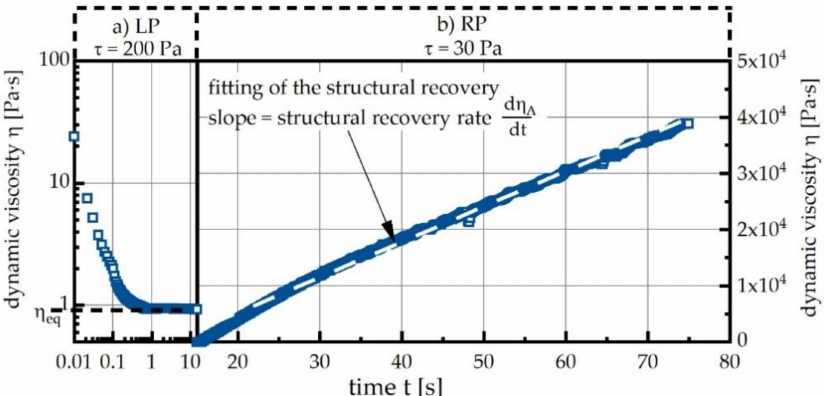
Figure 2. Exemplary depiction of the change in dynamic viscosity observed during the loading phase (LP) and the recovery phase (RP): ( a ) LP causes a non-linear decrease until the equilibrium dynamic viscosity η eq is reached; ( b ) fitting of the linear increase of η during the RP in order to determine the structural recovery rate d η A / dt; measurement of a cement paste at 20 ◦ C without superplasticizer starting at an age of 15